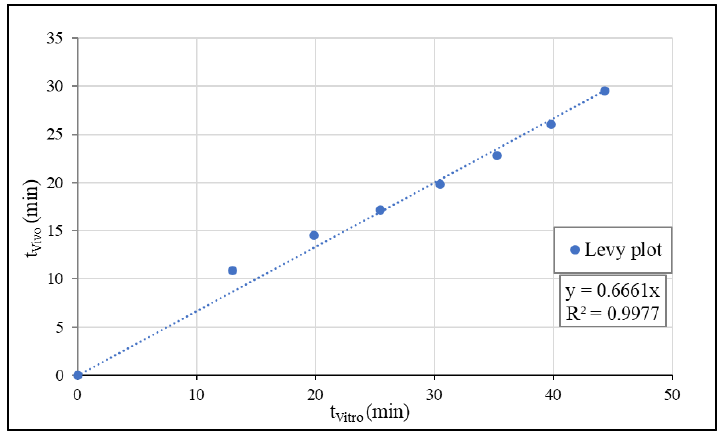
Figure 11. The Levy plot of IBU.